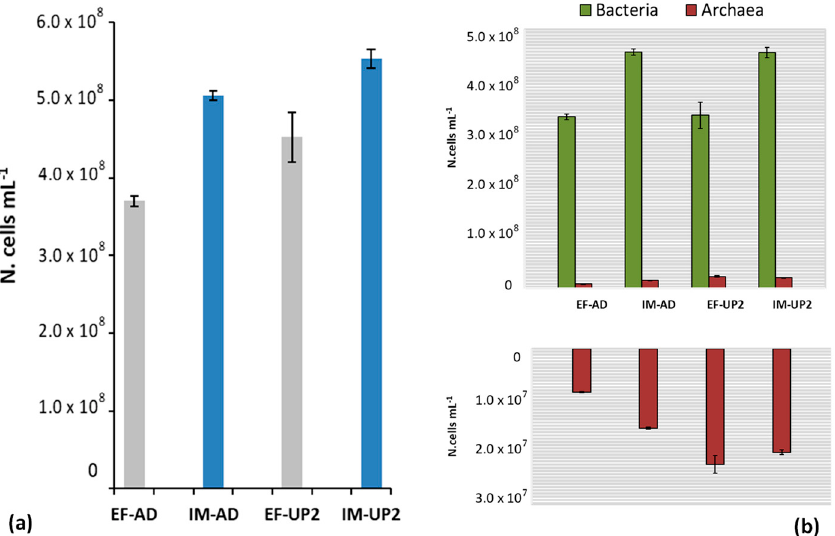
Figure 3. Microbial abundance (N. cells mL − 1 ) under different experimental conditions is reported. ( a ) Total microbial abundance detected in the effluent (EF, gray bars) and in the interstitial matrix (IM, blue bars), before (AD, anaerobic digestion) and after (UP2) H 2 addition, using DAPI staining; ( b ) Abundance of bacteria (green) and archaea (red) in the effluent (EF) and interstitial matrix (IM), before and after H 2 addition (AD and UP2, respectively) obtained by FISH technique and DAPI staining. At the bottom, the archaea are shown on a lower scale to highlight the differences.